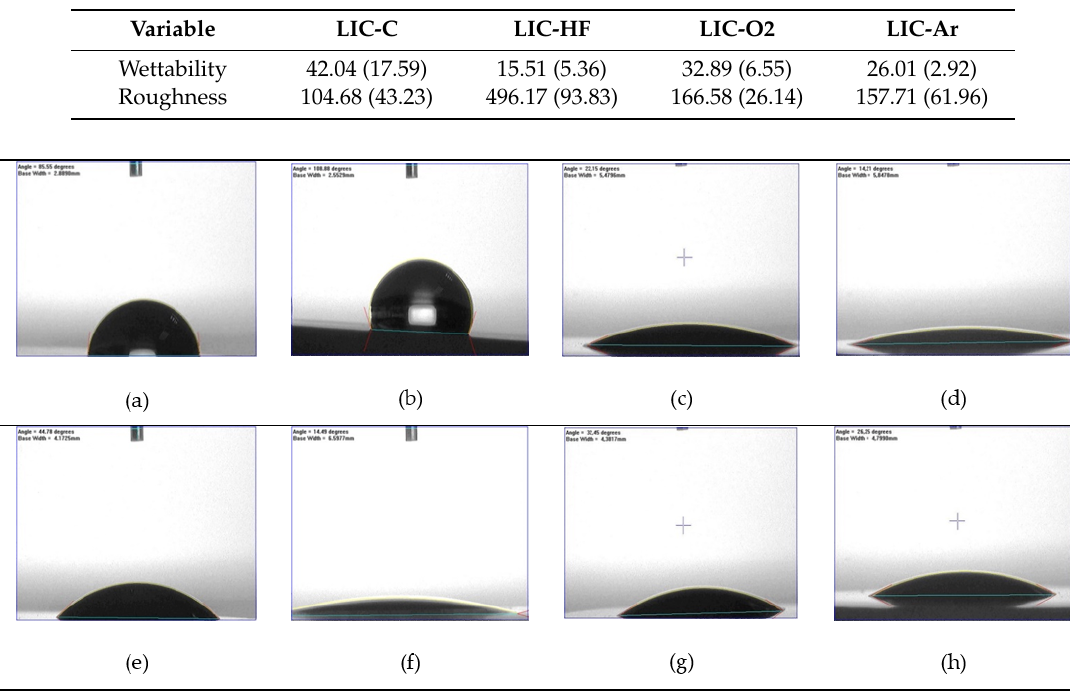
Table 5. Mean and standard deviation (SD) values of wettability (degree) and roughness (Ra, nm) in the RMC group. Variable